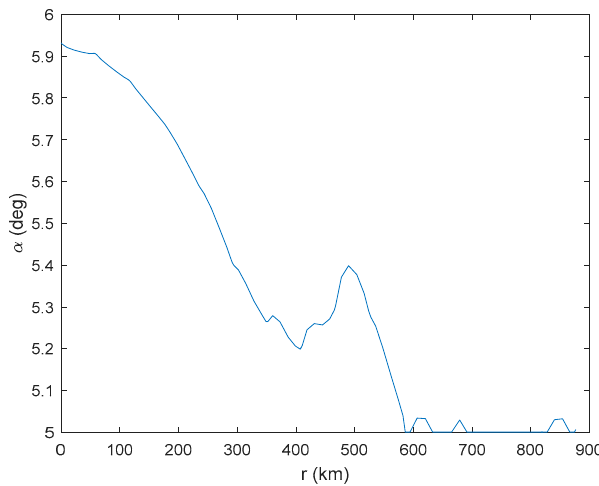
Appl. Sci. 2020 , 10 , x FOR PEER REVIEW 10 of 14 Figure 4. Optimal angle of attack at the initial altitude of 45 km. Figure 4. Optimal angle of attack at the initial altitude of 45 km.